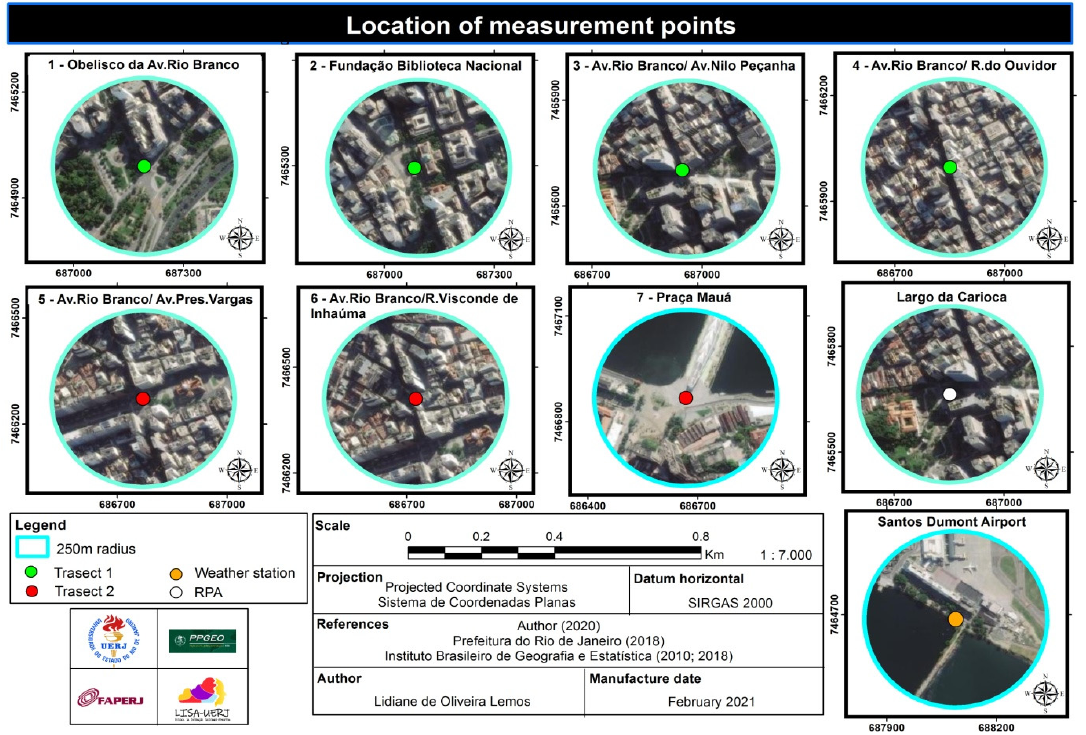
Figure 2. Location of measurement points. Avenida Rio Branco was divided into transect 1 (South-North) and transect 2 (North- South). Transect 1 comprises points: 1 (Obelisco da Avenida Rio Branco), 2 (Fundaç ã